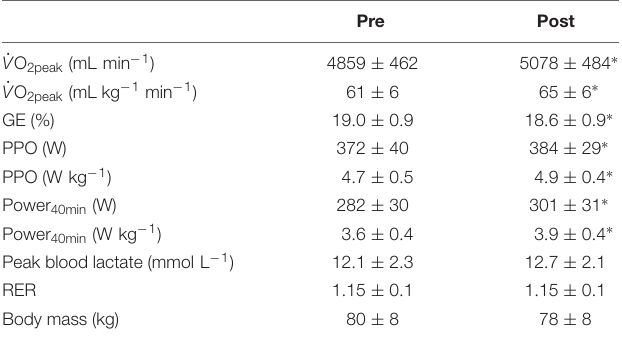
TABLE 1 | Pre- and post-test values of performance and physiological factors following the 12-week high-intensity training intervention in 60 well-trained cyclists. Pre Post